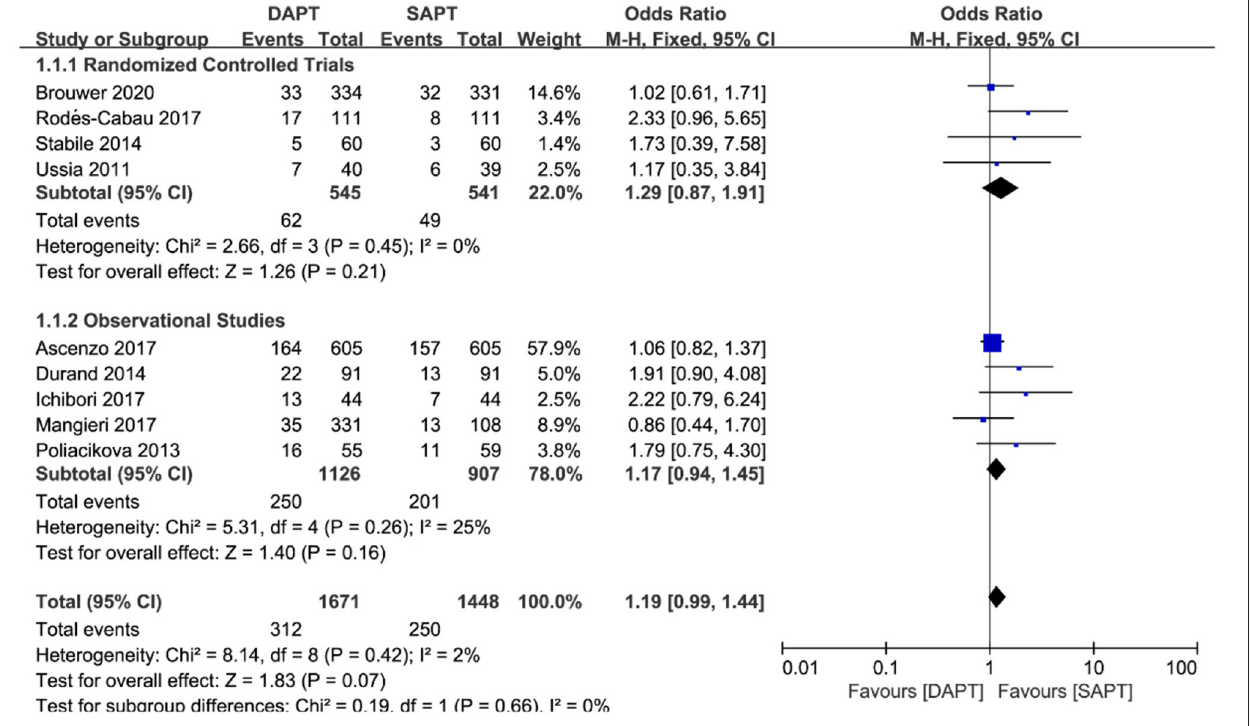
FIGURE 3 | Forest plot for major adverse cardiovascular events (MACE) with subgroup analysis stratified by study type at longest